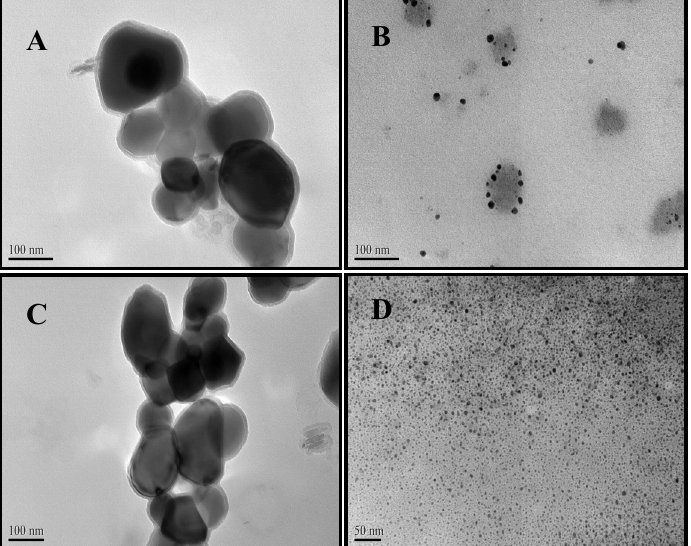
Figure 2. TEM images of Au and Ag NPs. Au NPs: ( A ) large spheres with average diameters of 126 ± 39 nm are violet. ( B ) red colloids have average diameters of 11 ± 4 nm Ag NPs: ( C ) yellow Ag NPs suspensions have average sizes of 132 ± 5 nm; ( D ) silver seed-like NP with an average long axis of 5 ± 1 nm are